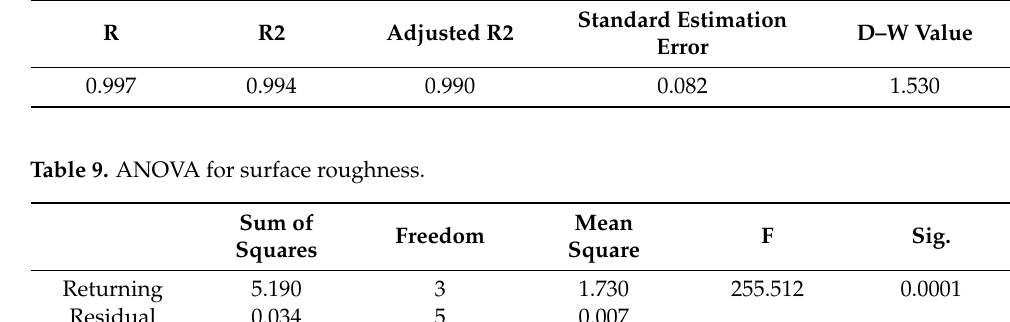
Table 8. Model summary.